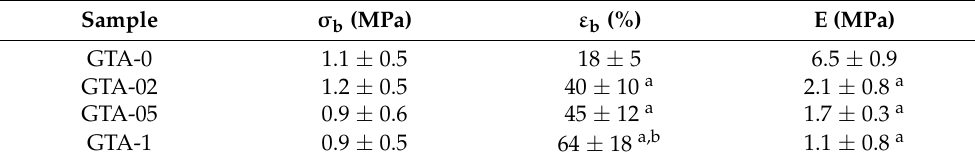
Table 4. Strain at break, σ b , stress at break, ε b , and Young’s modulus, E, of GTA gelatin films. Each value is the mean of at least seven determinations and is reported with its standard